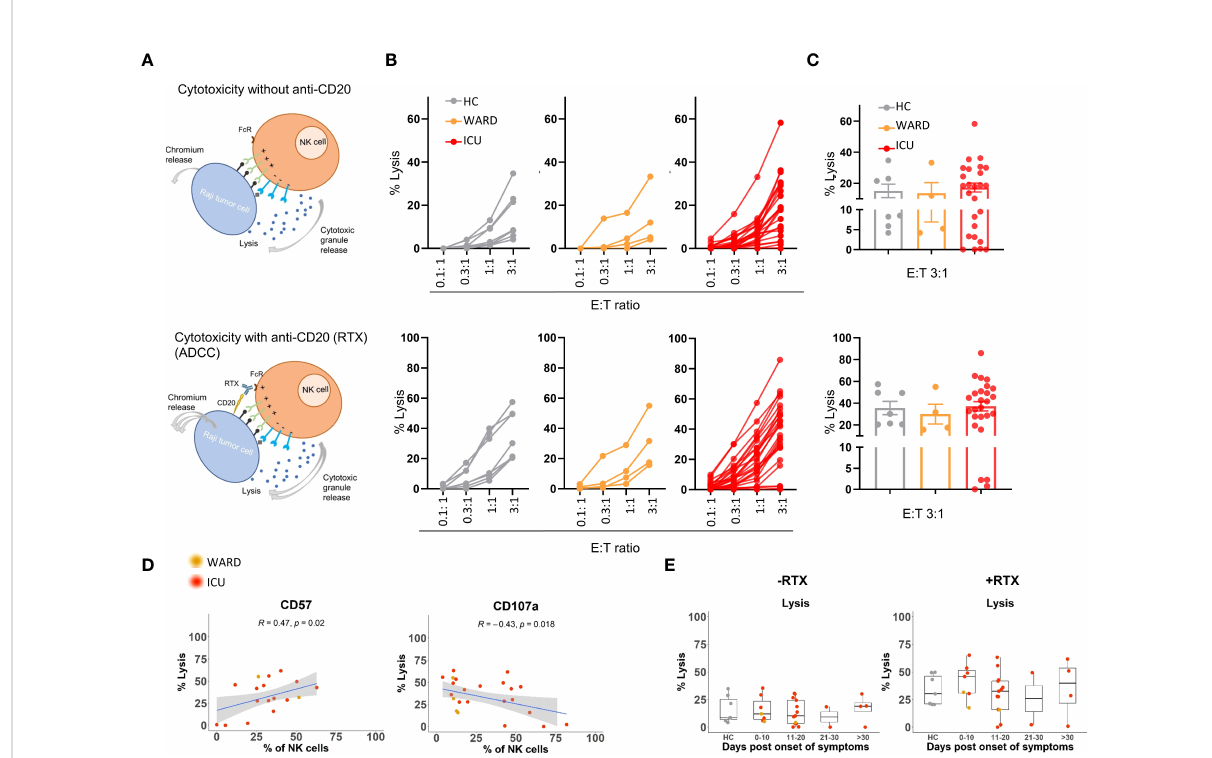
FIGURE 5 Direct and indirect (ADCC) cytolytic activities of NK cells from WARD and ICU patients. (A) Schematic overview of NK cell killing without or with anti-CD20 (Rituximab, RTX). Enriched NK cells were incubated for 4h with Chromium 51-labeled Raji cells and the cytolytic activity (% lysis) was calculated by the release of Chromium 51 as described in M&M. (B) Percentage lysis at indicated E:T ratio ’ s for healthy controls (HCs) (n = 7) (left, grey), WARD (n = 4) (middle, orange), and ICU (n = 26) (right, red) COVID-19 patients. (C) Representative bar graphs with the percentage of lysis for E:T 3:1 ratio are shown. Each symbol represents a single patient. (D) Pearson correlation between the percentage of lysis for E:T 3:1 ratio and the expression of CD57 and CD107a on NK cells of COVID-19 patients. R = correlation coef fi cient. (E) Data from panel C plotted after grouping of WARD and ICU patients according to the days post onset of COVID-19 symptoms. ADCC, Antibody-dependent cellular